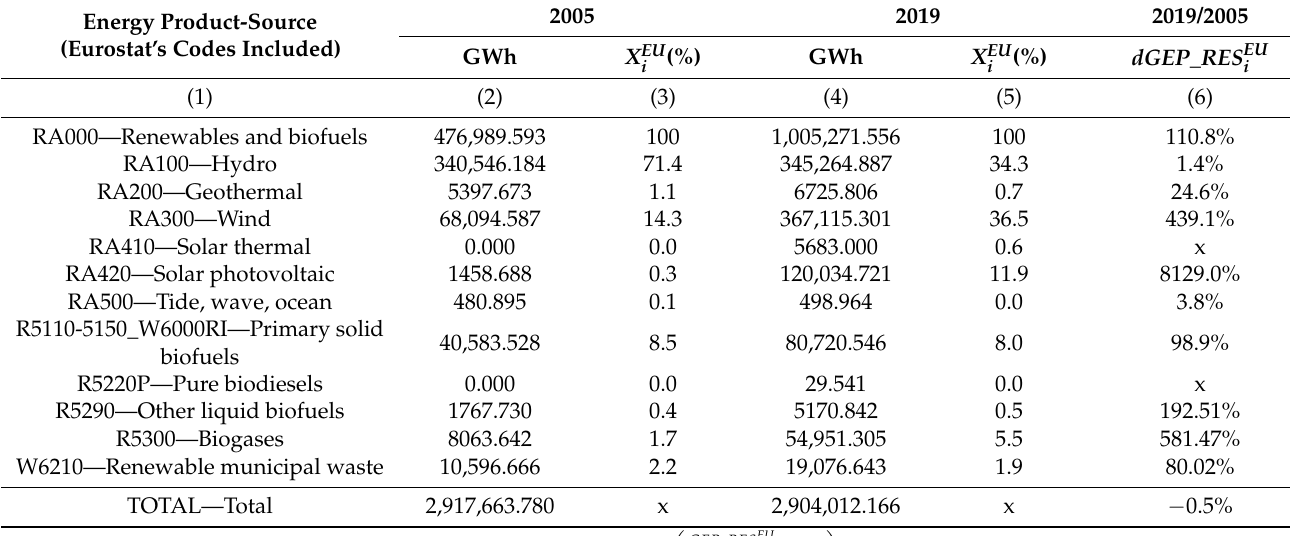
Table 2. Gross electricity production from RES and the total gross electricity production in EU-27 in 2005 and 2019. Energy